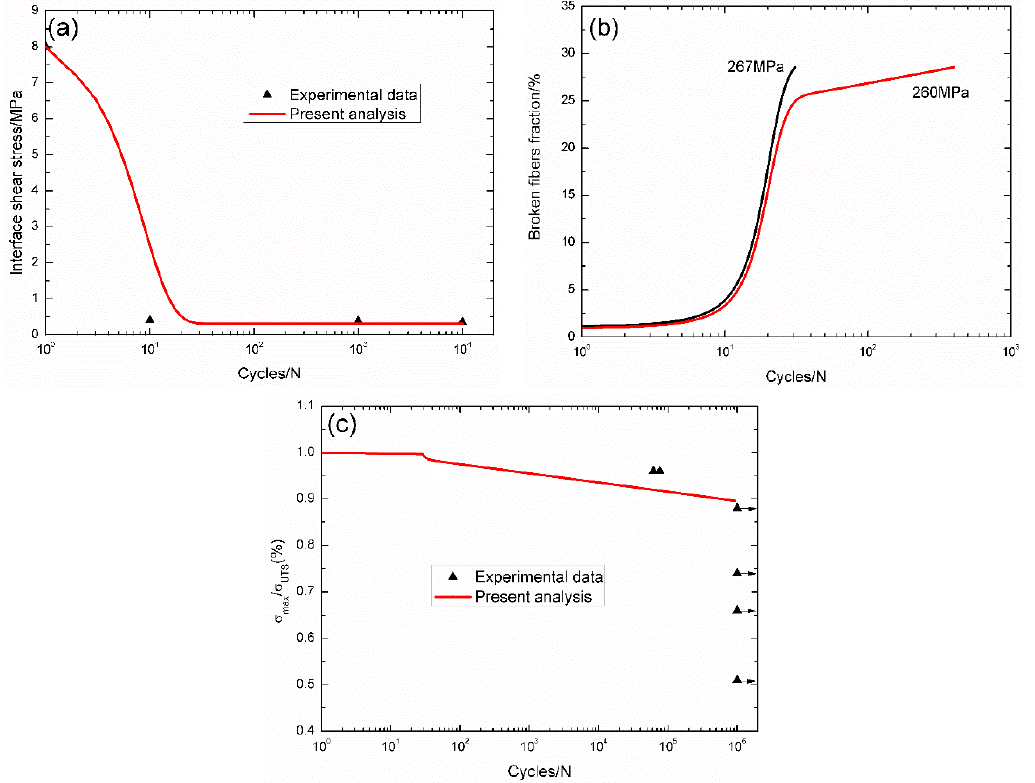
Figure 4. ( a ) The interface shear stress versus applied cycles; ( b ) the broken fibers fraction versus applied cycles; and ( c ) the fatigue life S–N curves of experimental data and theoretical analysis for unidirectional C/SiC composite at room temperature. Table 1. The material properties of unidirectional (UD), cross-ply (CP), 2D, 2.5D and 3D C/SiC composites at room temperature.